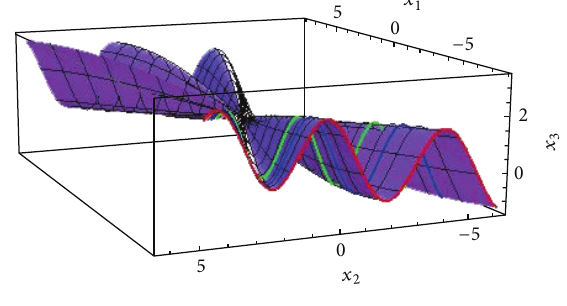
Figure 2: Integral